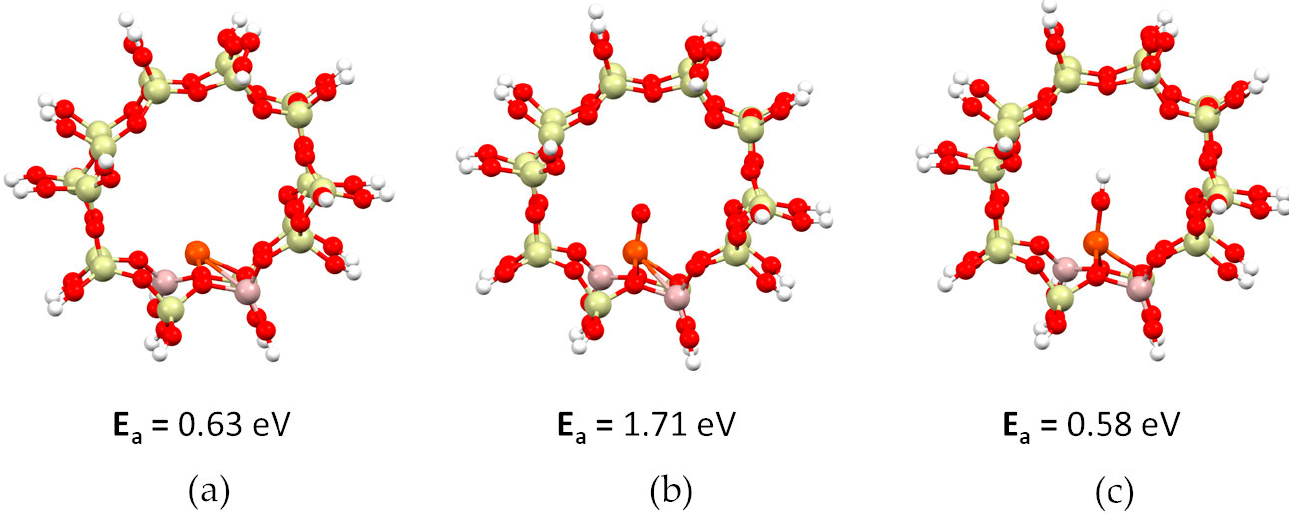
Figure 1. Structure with iron adsorbates inside the pore (energy of adsorption below the structure): ( a ) ZSM-5 with iron, ( b ) ZSM-5 with iron oxide, and ( c ) ZSM-5 with iron hydroxide. Atoms’ color: iron—orange, aluminum—pink, silicon—yellow, oxygen—red, hydrogen—white.